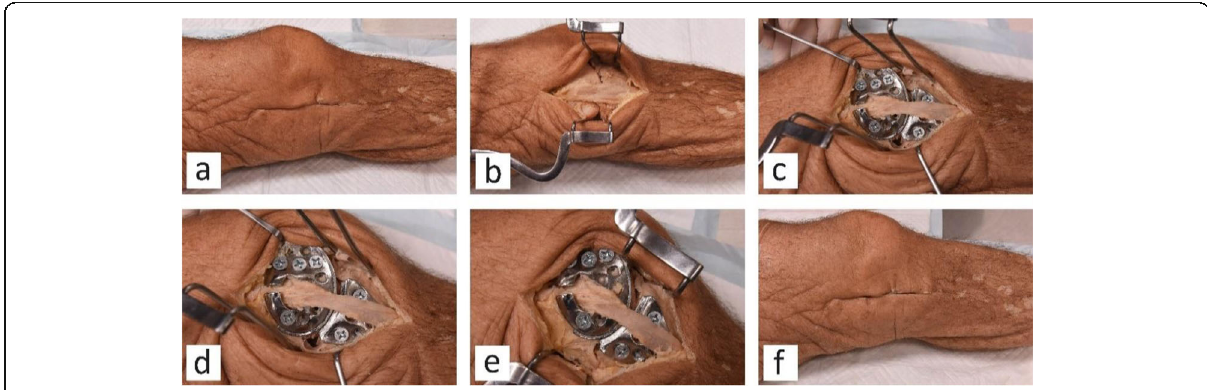
Fig. 10 a incision made in the medial side of the specimen, b exposed MCL, c joint at 0°, d joint at ~ 30°, e joint at ~ 60°, f closed incision after attachment of the